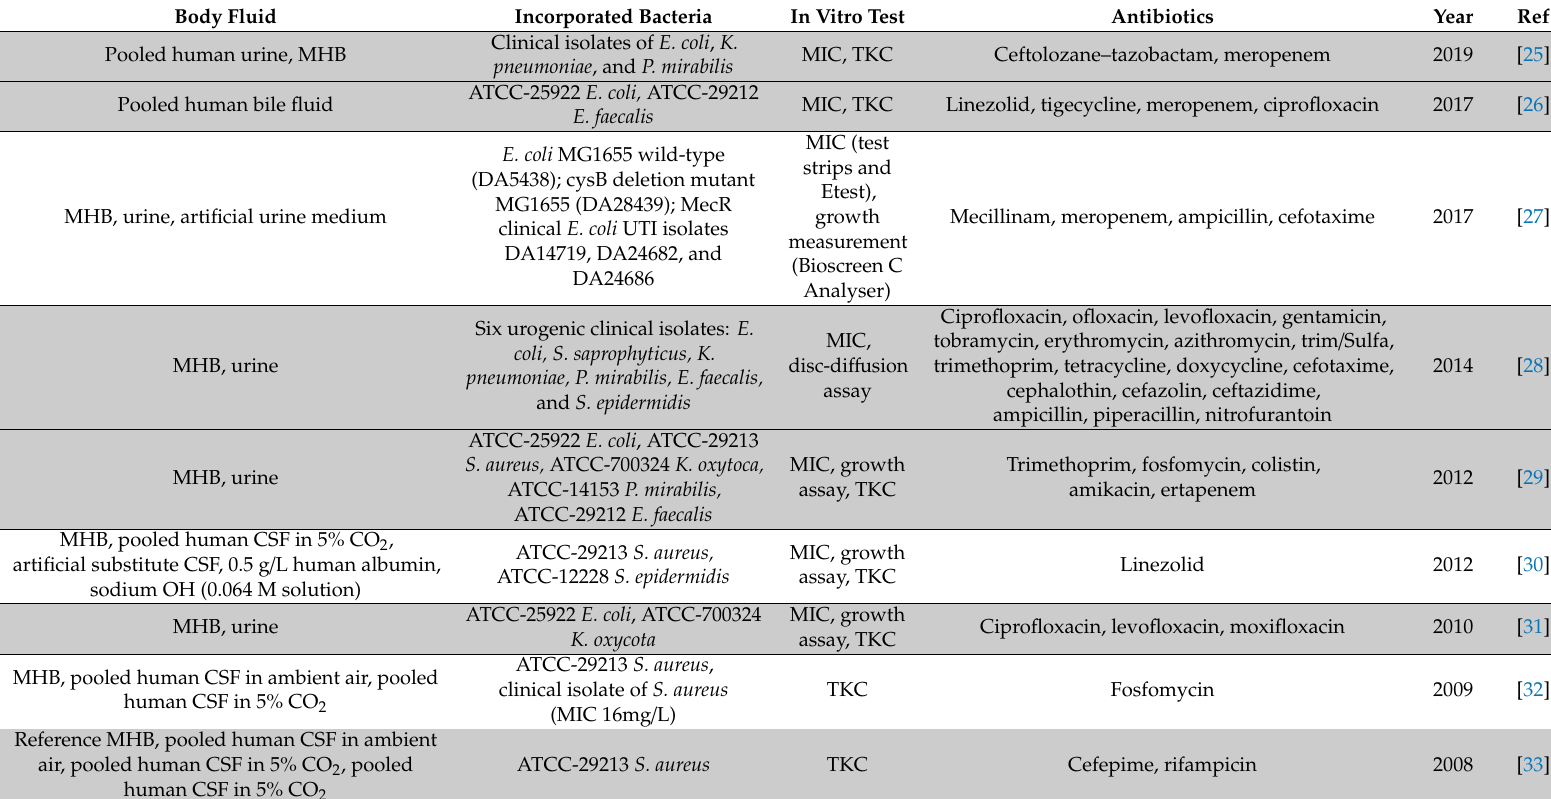
Table 3. Body fluids as